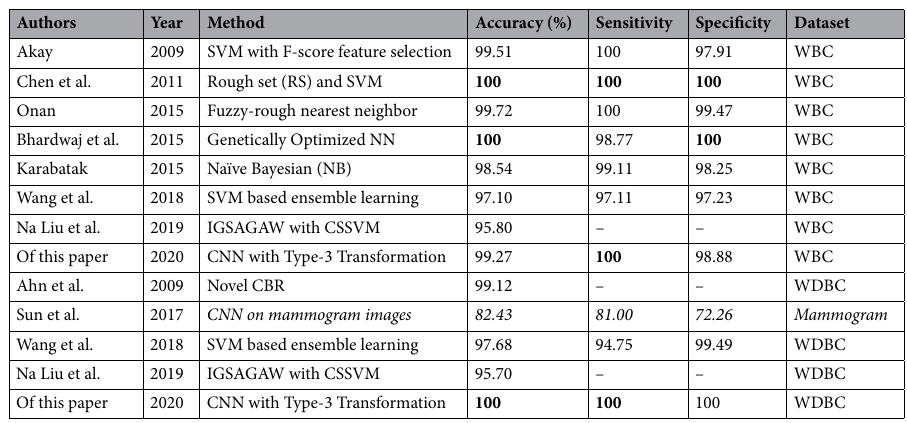
Table 8. Comparison of the proposed method with other methods. Significant values are in [bold/italics].